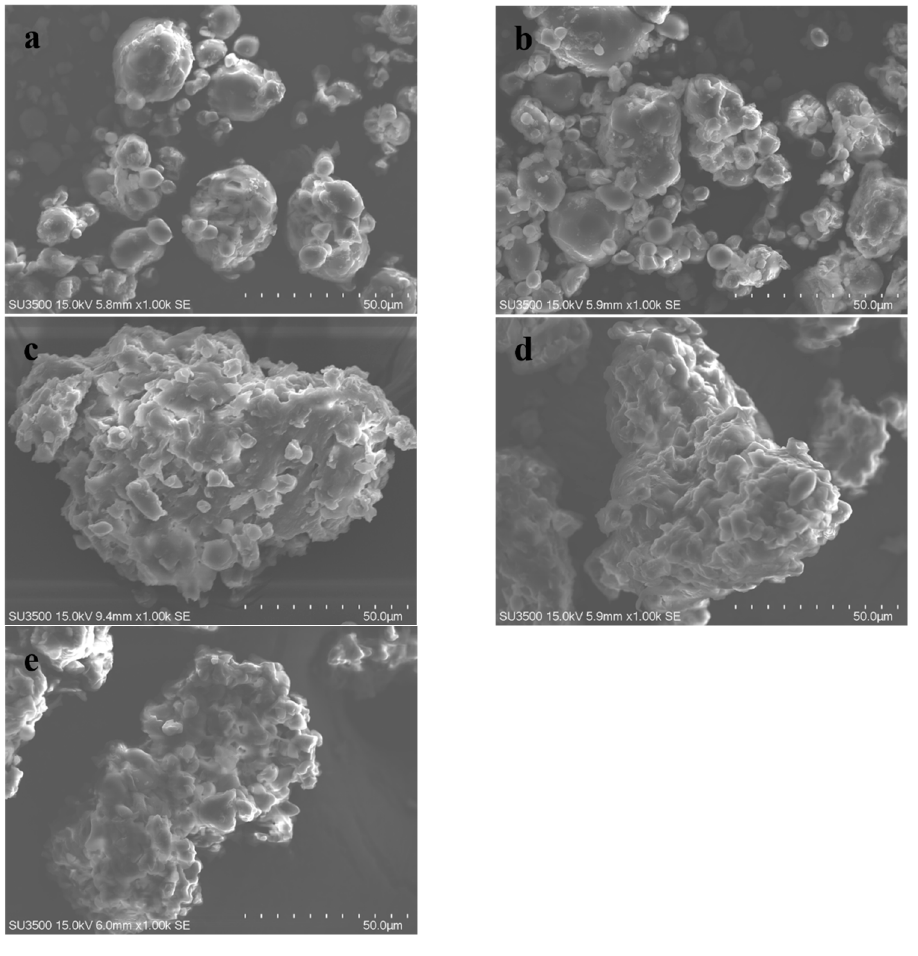
Figure 7. SEM images of native oat ( a ), oat in mixing zone ( b ), cooking zone ( c ), melting zone ( d ), and extrudates ( e ) (×1.00 k magnification).